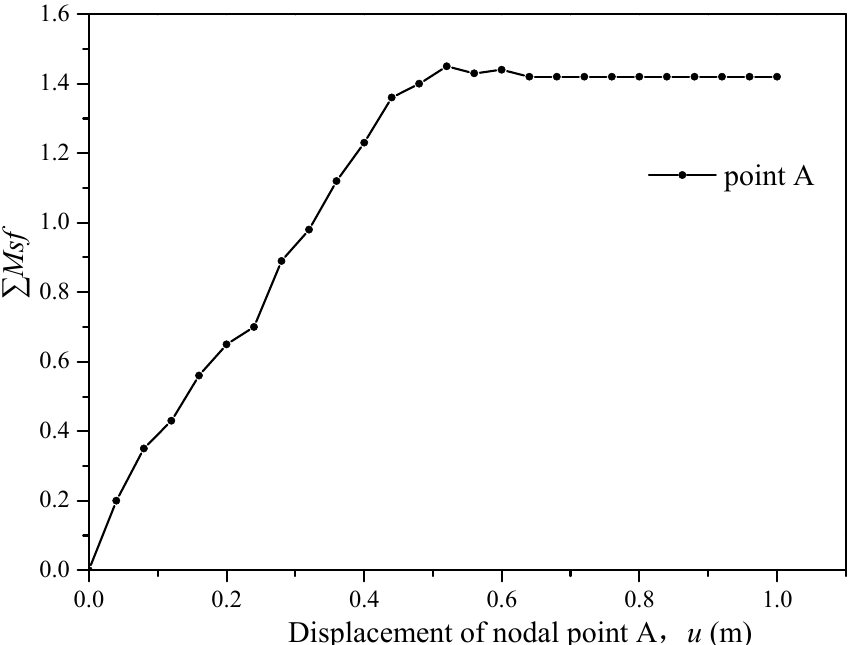
Figure 6. ∑ Msf (equal to the factor of safety (FOS)) versus the displacement of nodal point A at the berm crest.